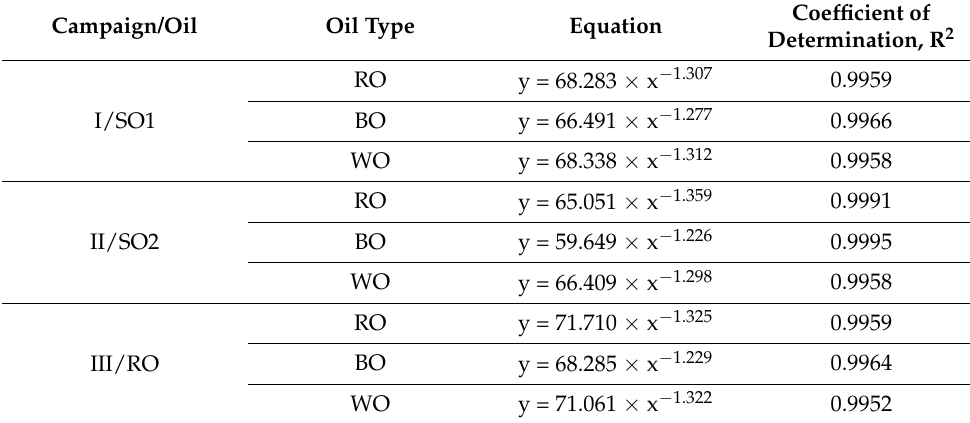
Table 4. Mathematical correlation of vegetable oils viscosity (mPa × s) with temperature ( ◦ C). Campaign/Oil Oil Type